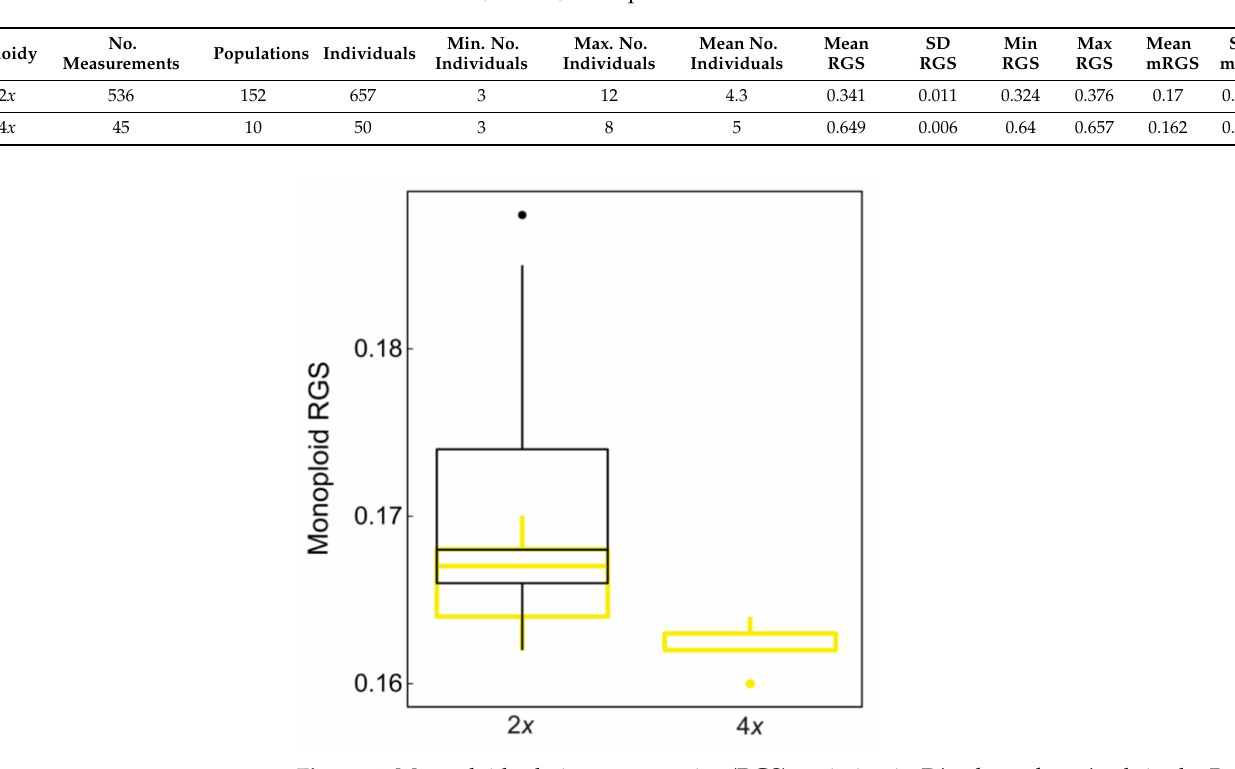
Figure 4. Monoploid relative genome size (RGS) variation in Dianthus sylvestris s.l. in the Balkan Peninsula and the Alps. Black colored box indicates the variation of the complete diploid dataset (152 DNA-diploids, 2 x ), whereas yellow color corresponds to 15 DNA-diploids (2 x ), and 10 DNA- tetraploid (4 x ) populations of D. sylvestris subsp. sylvestris. Boxes correspond to 25 and 75 percentiles, horizontal lines to medians, whiskers 5 to 95 percentiles, and circles to